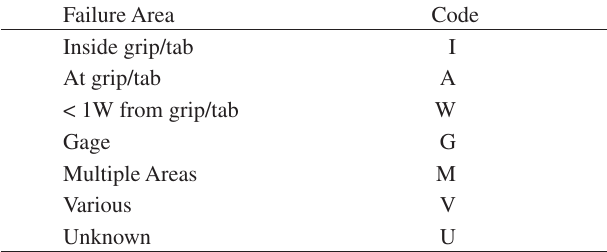
Table 2. Codes related to the second characteristic (“area”) of the failure mode 20.